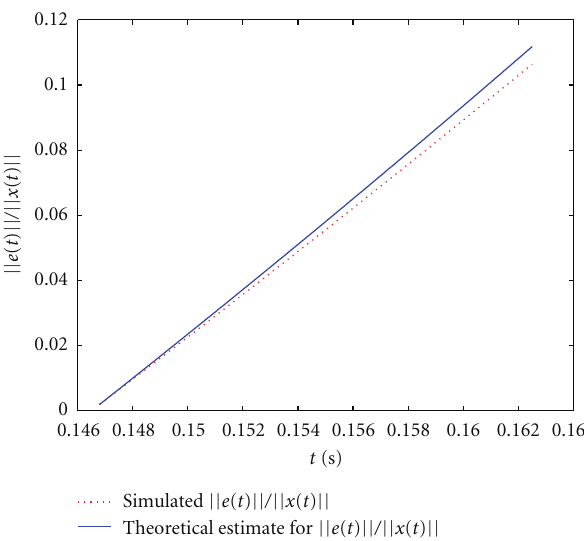
Figure 6: Evolution of (cid:3) e ( t ) (cid:3) / (cid:3) x ( t ) (cid:3) obtained by simulation and its estimation according to (19) for σ = 0 .